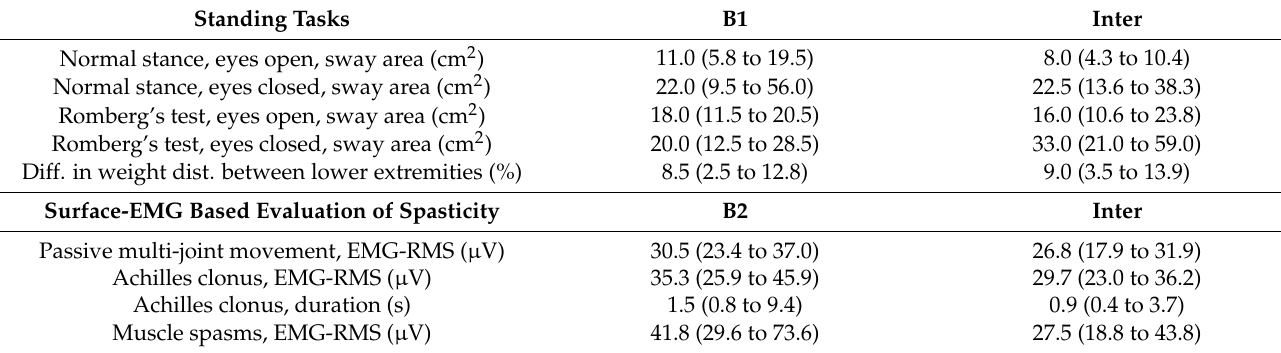
Figure 4. Intermediate carry-over effects of transcutaneous spinal cord stimulation on standing ability. ( a ) (i) Trajectories of the center of pressure in anterior–posterior and medial–lateral directions recorded during 30 s of normal standing with eyes open in B1 and assessments I1 and I2 of Inter; participant 10. Group results in B1 and Inter of postural sway during (ii) normal standing and (iii) Romberg’s test for 30 s with eyes open and eyes closed as indicated. ( b ) Difference in weight distribution (percentage of body weight) between lower extremities during 30 s of normal standing with eyes open shown for B1 and Inter. B1, baseline assessment conducted ~24 h pre-intervention; Base, baseline evaluation; Inter, evaluation of intermediate carry-over effects comprising two assessments conducted immediately (I1) and two hours (I2) post-intervention. All group results are illustrated by box plots. Bold horizontal lines within boxes are medians; boxes span the interquartile range. Whiskers extend to the lowest and largest values that are neither outliers (illustrated as circles) nor extreme values (asterisks). Bracket and asterisk denote significant results of post-hoc pairwise comparisons (*, p < 0.05; **, p < 0.001). Table 3. Group results of complementary